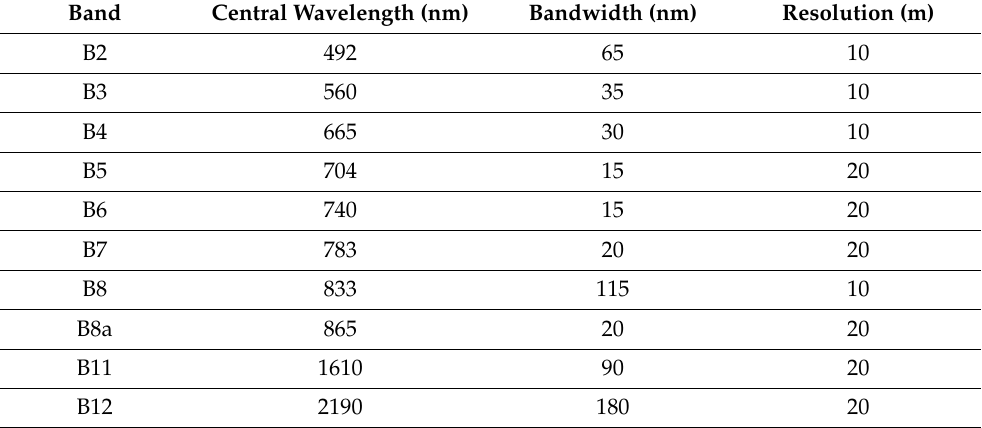
Table 2. Sentinel-2 MSI spectral bands characteristics.